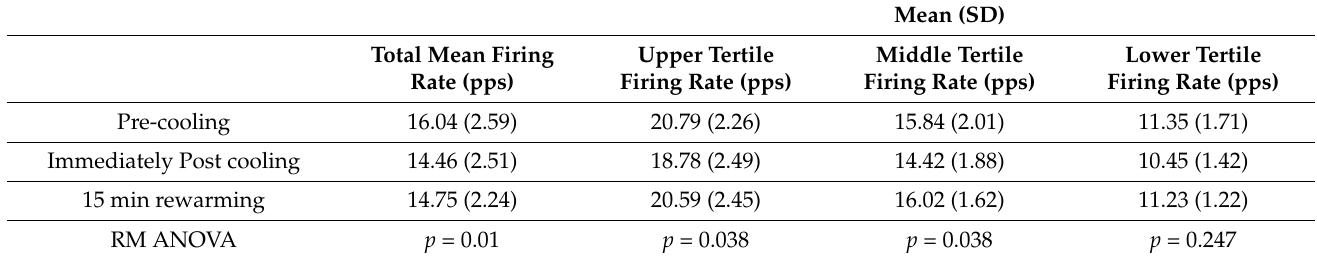
Table 3. Descriptive statistics and RM ANOVA for MFR.